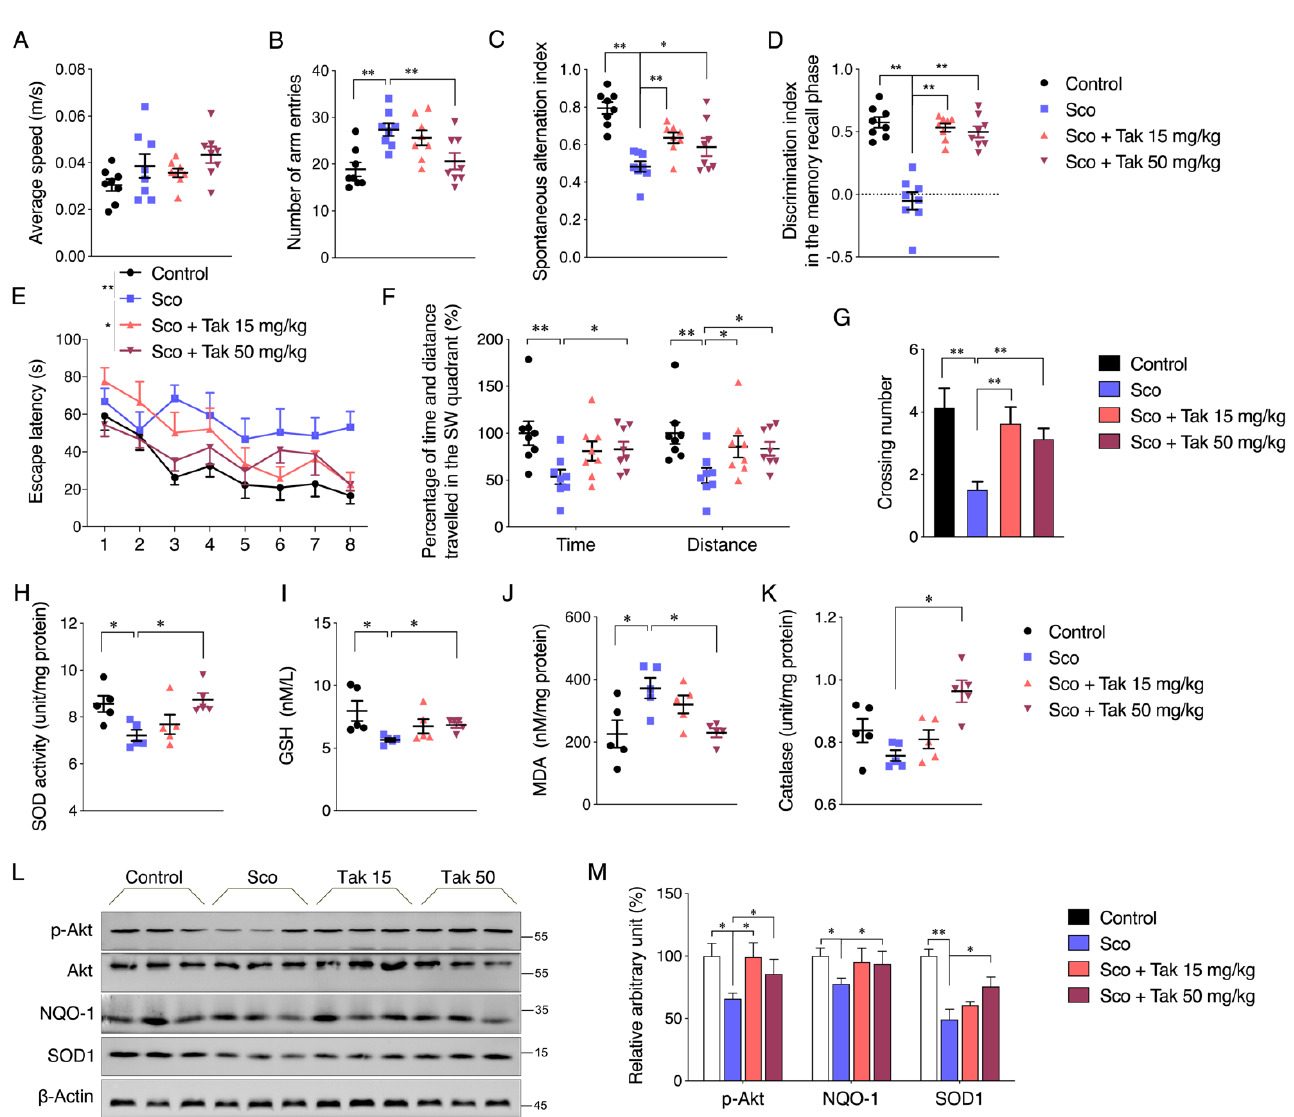
Figure 6. Tak supplementation ameliorates scopolamine-induced learning and memory impairments. Mice were intraperi- toneally administered with Tak at the dose of 15 and 50 mg/kg/day for 9 days followed by 1 mg/kg scopolamine injection 30 min before behavioral tests. ( A ) Travelling speed at open field. Total number of arm entries ( B ) and spontaneous alternation index ( C ) in the Y maze. ( D ) Discrimination index in the new object recognition test. ( E ) Escape latency of acquisition trial in the MWM test. ( F ) Percentage of time and distance spent in SW quadrant of probe trial. ( G ) Number of platform crossings in probe trial. The hippocampus tissues were collected after the treatment for analysis of ( H ) SOD activity, ( I ) GSH level, ( J ) MDA level, ( K ) CAT activity, and protein levels of p-Akt, NQO-1, and SOD1 (( L ): western blot images; ( M ): statistical analysis). The values are presented as the mean ± S.E.M. n = 8 for behavioral tests, n = 5 for biochemical tests. * p < 0.05 and ** p < 0.01 between the connected groups. Sco: Scopolamine.